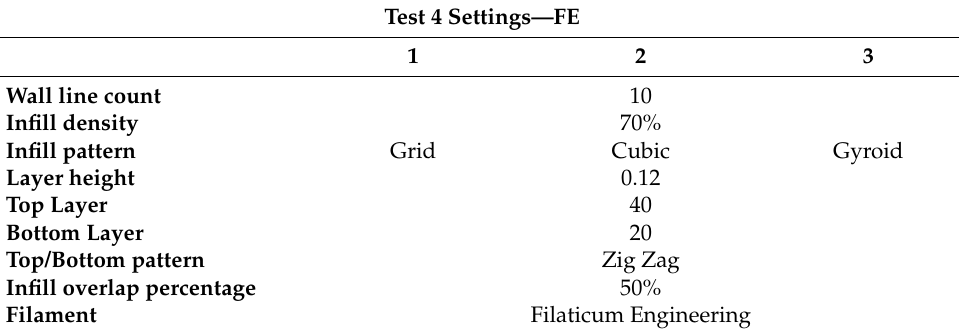
Table 8. Punch settings of Test 4—FE.